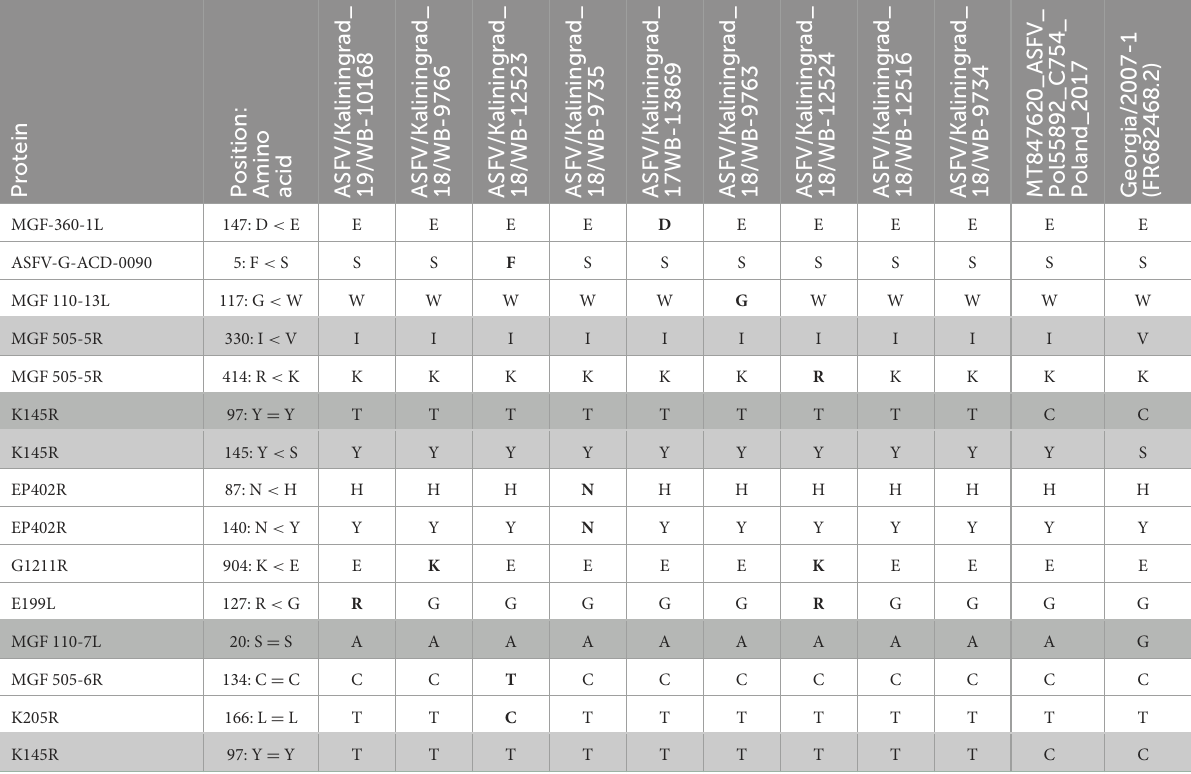
TABLE 3 Amino acid positions affected by the synonymous ( = ) and nonsynonymous ( < ) SNPs in the predicted proteins.